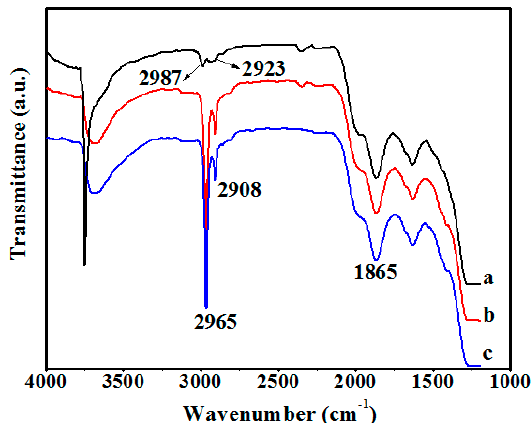
Figure 2. IR spectra of fumed silica after (a) reaction with vapors of diethyl carbonate; (b) reaction with vapors of hexamethyldisilazane at 120 °C subsequent vacuum treatment of surface at 300 °C; (c) interaction with vapors of the diethyl carbonate and vacuum treatment at 300 °C.